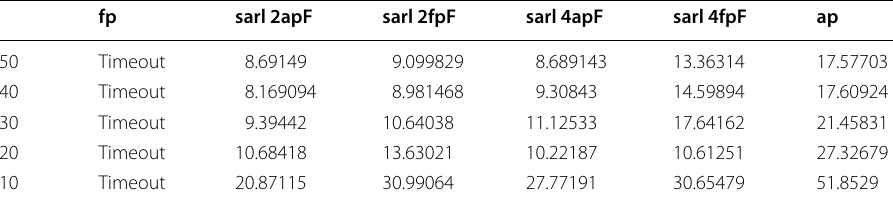
Table 13 Running times of different algorithms on the Bible dataset